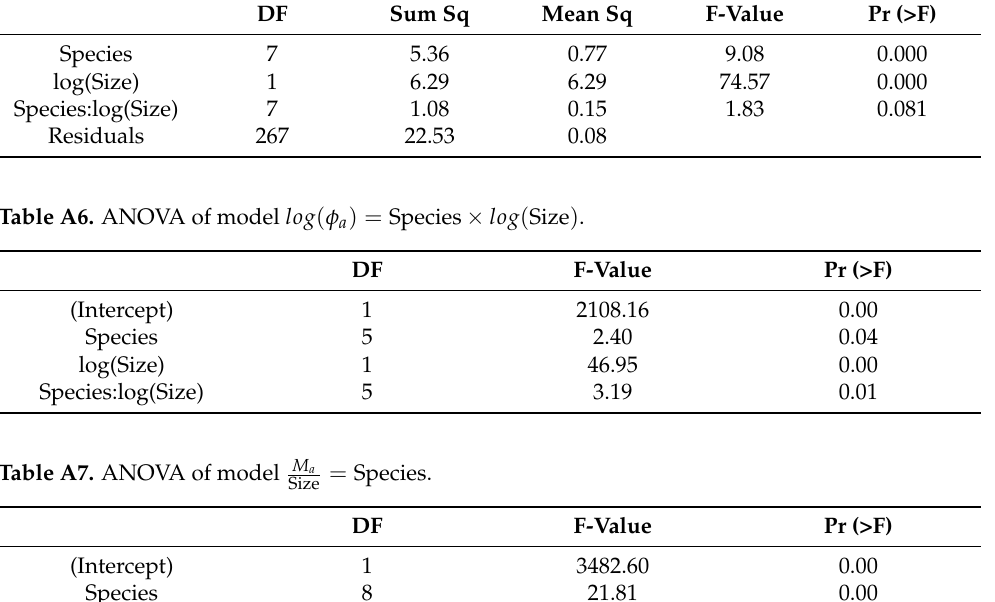
Table A5. ANOVA of model log ( M est